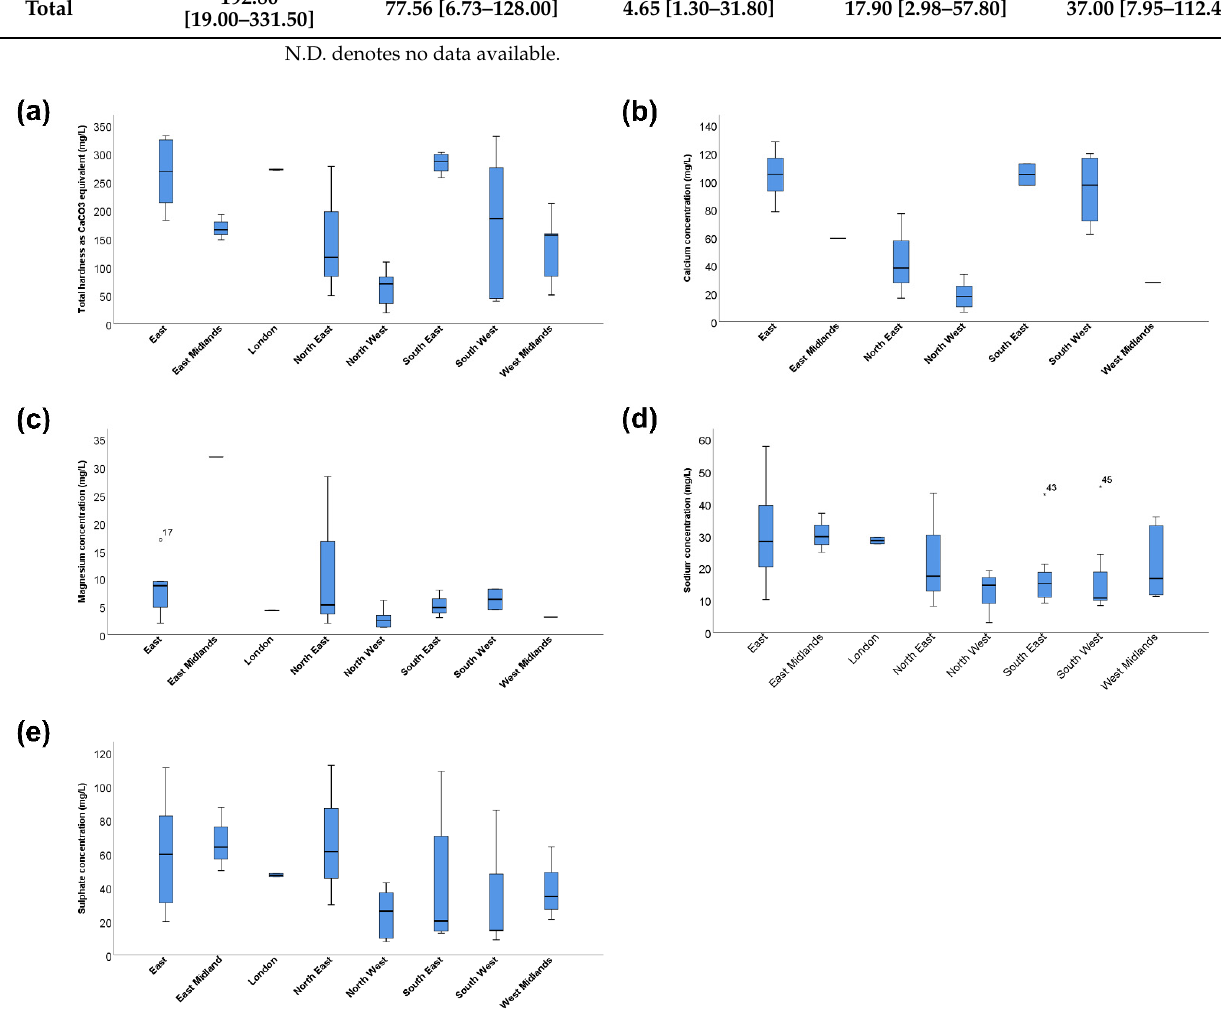
Figure 2. Distribution of the mineral composition of tap water across England Mineral composition of tap water by region (mg/L). ( a ) Total water hardness as CaCO3 equivalent ( b ) Calcium concentration ( c ) Magnesium concentration ( d ) Sodium concentration ( e ) Sulphate concentration. ○ Outlier (value > 1.5 IQR); ★ Extreme outlier (value > 3 IQR). Table 3. Comparison of water composition by region in England.